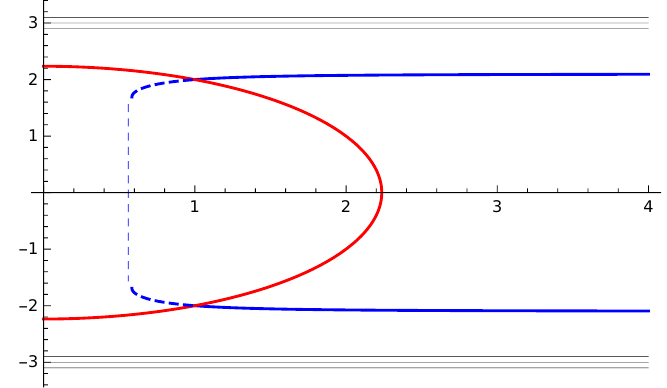
Figure 2 . Extendend brane